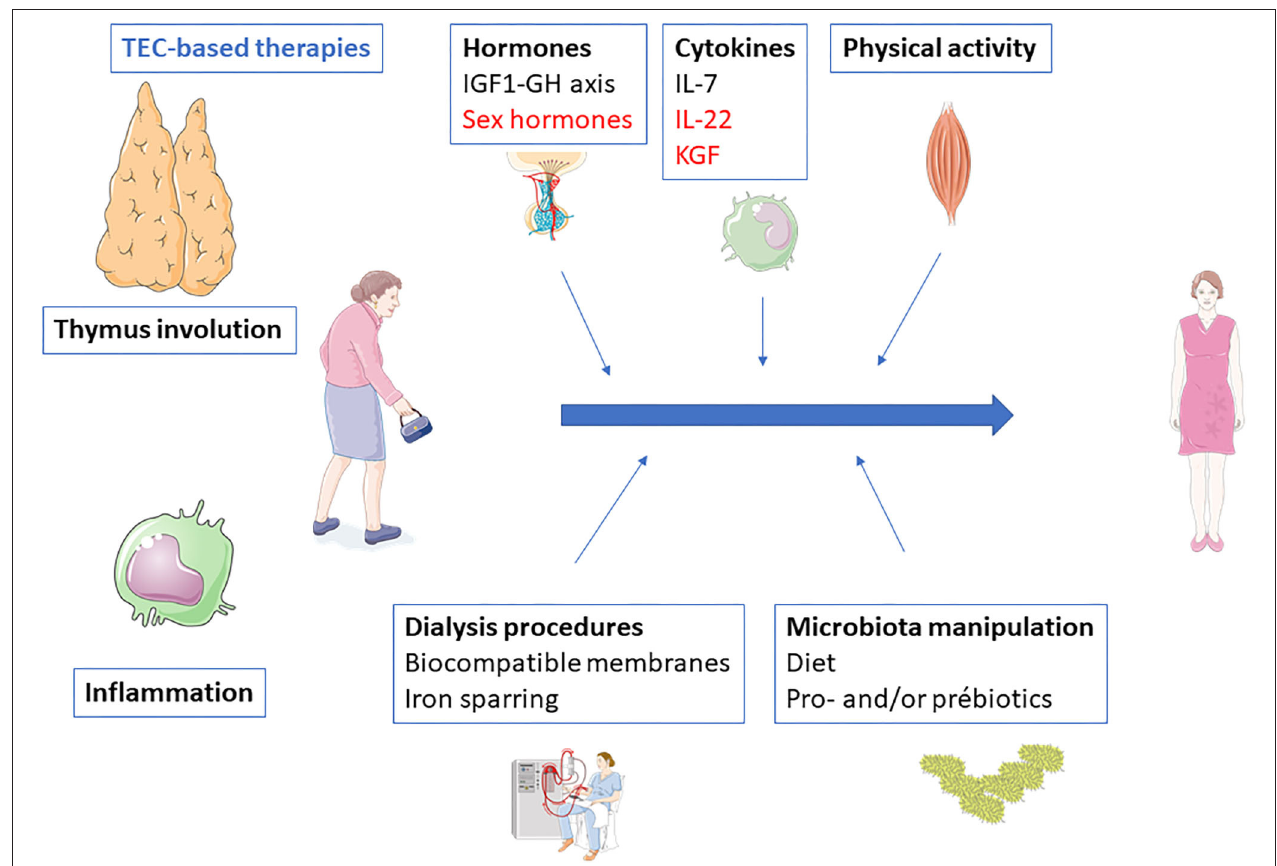
FIGURE 2 | Potential therapeutic interventions to prevent or reverse end-stage renal disease-related inflammaging. Black, interventions with evidences; Blue, interventions without clinical evidence but with strong background and potentiality; Red, interventions with evidences of